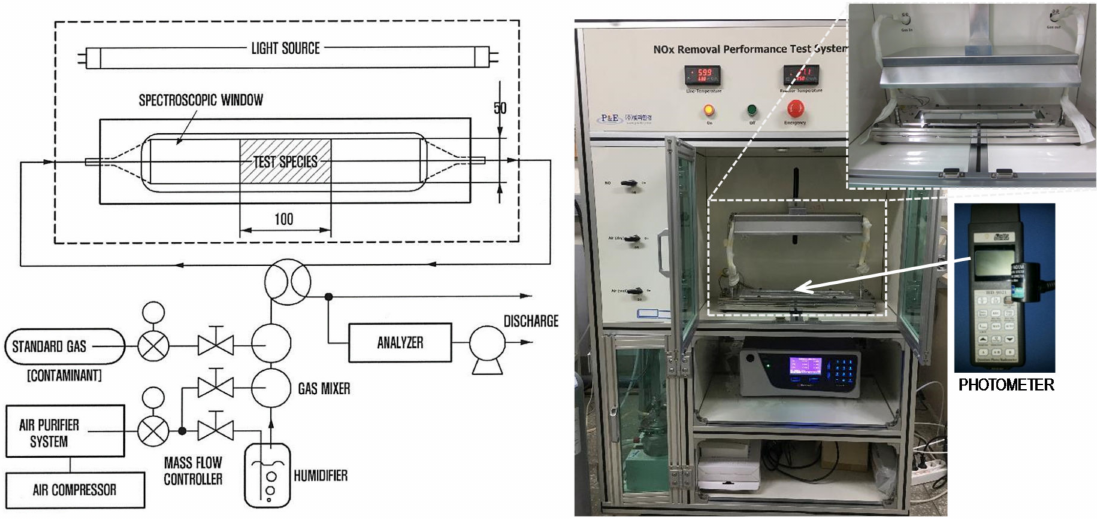
Figure 3. Test setup for nitrogen oxides (NO x )